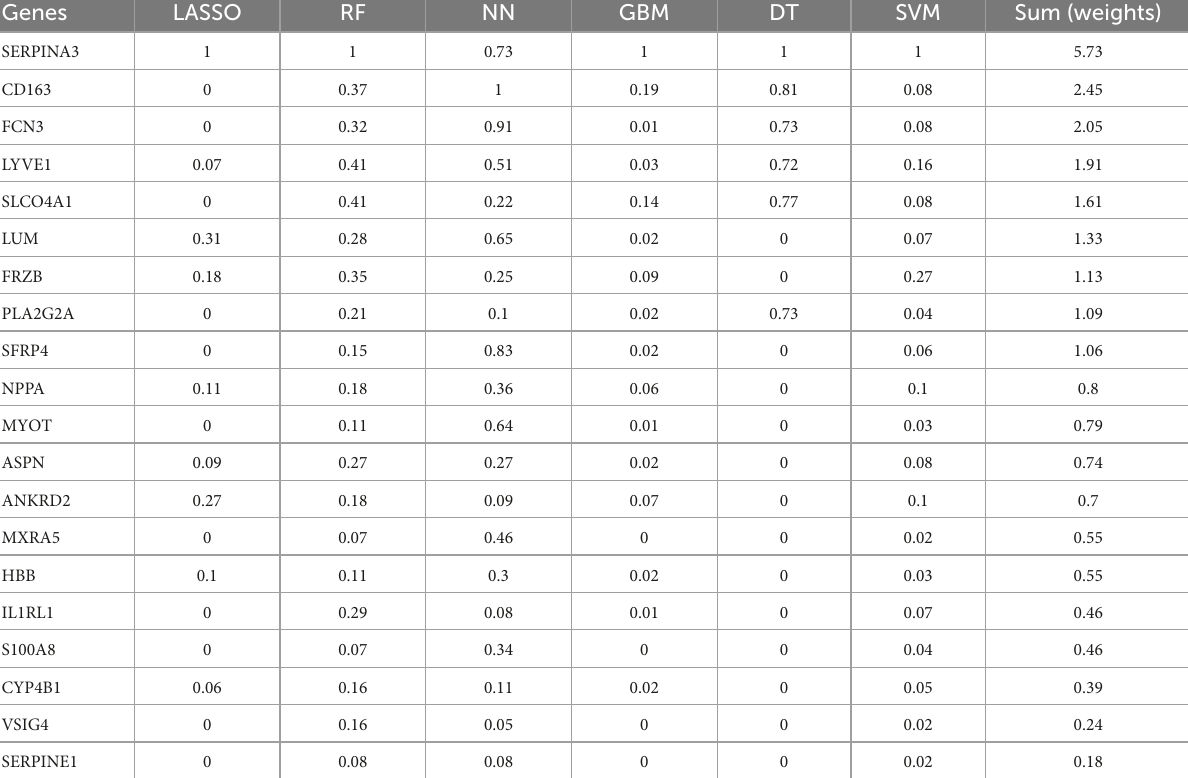
TABLE 3 The summed normalized weights of 20 differently expressed genes (DEGs) in six classifications machine learnings (MLs).